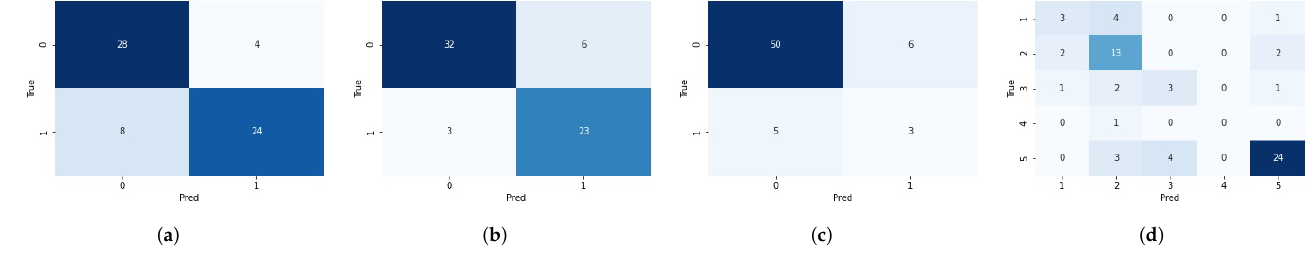
Figure 12. The confusion matrices on the hold-out test data for predicting ( a ) GBM vs. LGG, ( b ) IDH mutant vs. IDH wild type, ( c ) 1p/19q codeleted vs. 1p/19q intact, and ( d ) the five glioma subtypes